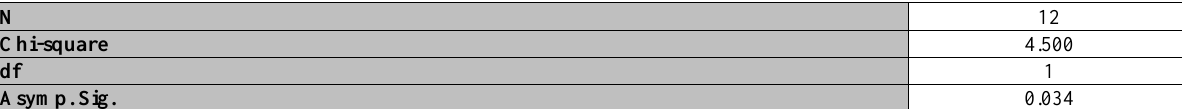
Table 11. Reductions in Production or Manufacturing Capacities (Friedman)